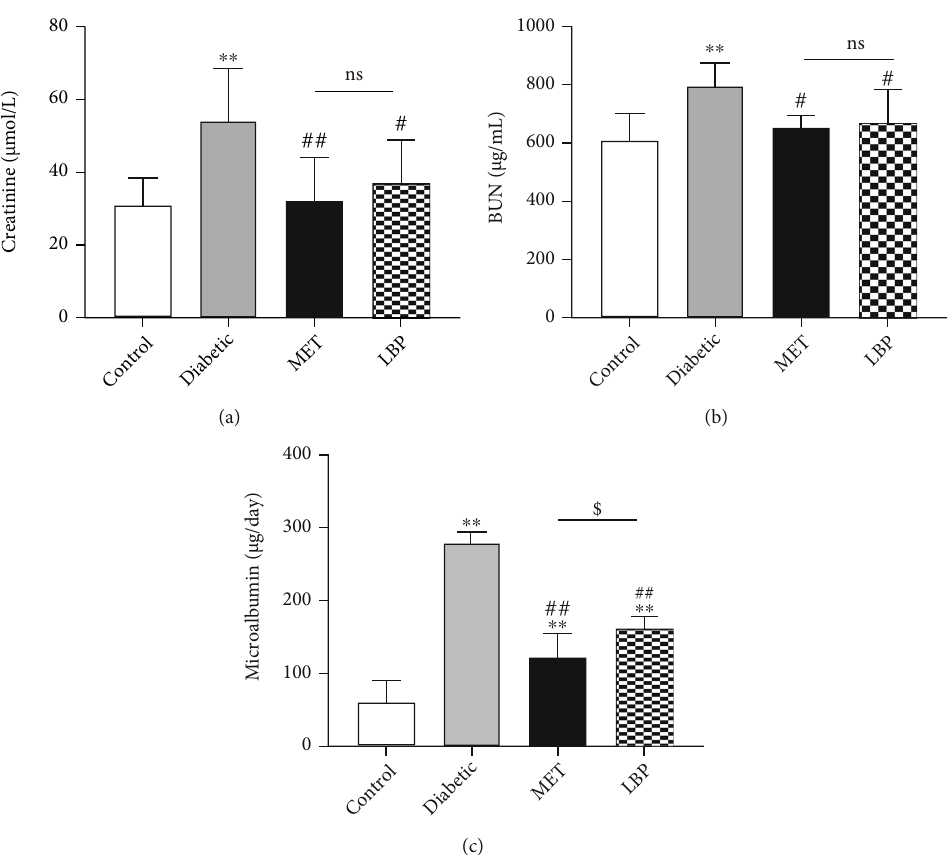
Figure 2: E ff ects of LBP treatment on creatinine, blood urea nitrogen, and microalbumin in diabetic mice: (a) creatinine in serum; (b) urea nitrogen in serum; (c) microalbumin (24 h) in urine. Data are expressed as the mean ± SD ( n = 6 -9 mice per group). ∗ Control vs. other groups, ∗ p < 0 : 05, ∗∗ p < 0 : 01 ; # diabetic vs. other groups, # p < 0 : 05, ## p < 0 : 01 ; $ MET vs. LBP, $ p < 0 : 05, $$ p < 0 : 01 ; ns means no signi fi